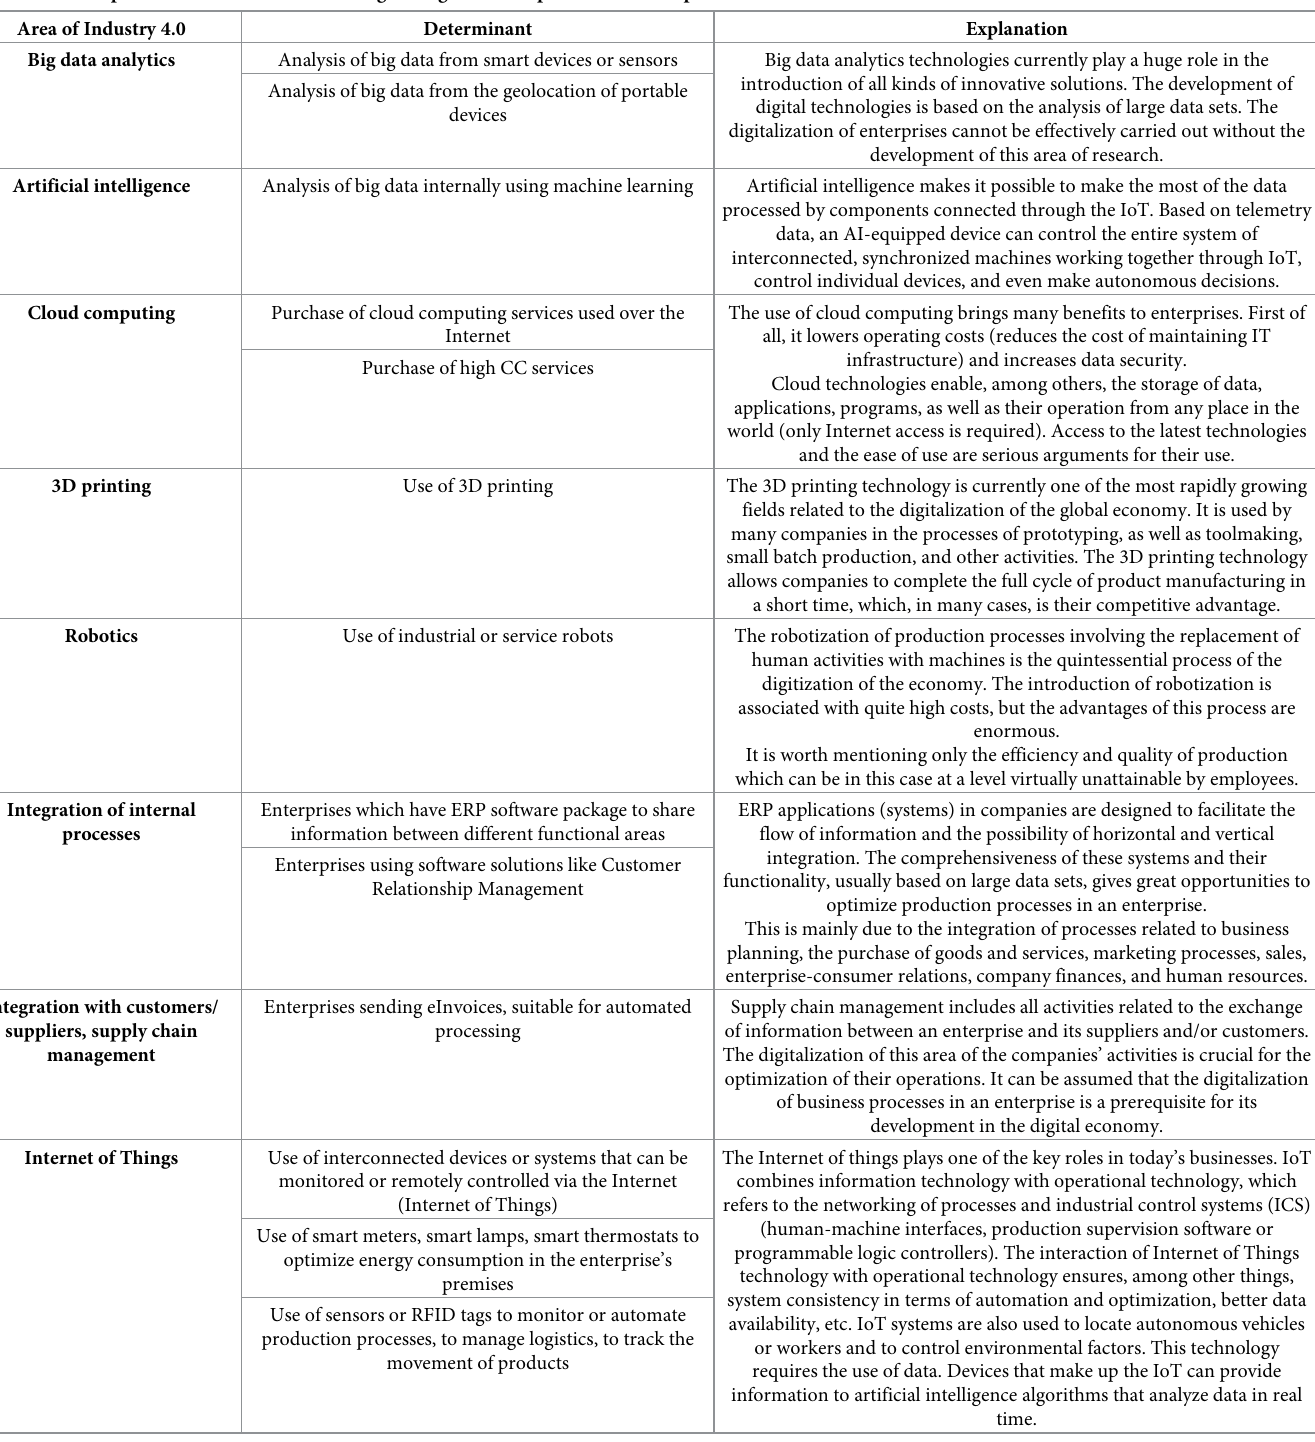
Table 5. The adopted determinants characterizing the digitalization processes of enterprises in the CEE countries. Area of Industry